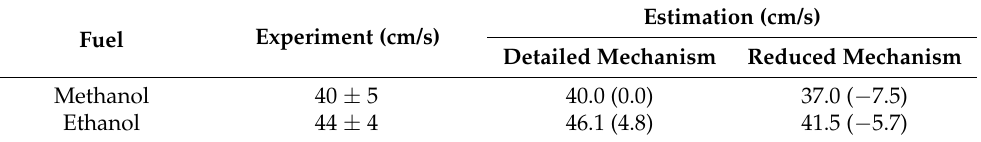
Table 4. Comparison of simulation and experimental results for the laminar burning velocity of methanol and ethanol under stoichiometric conditions and atmospheric pressure [36,37]. In brackets, the relative deviations from the experimental data are defined as 100* (estimated value − measured value)/measured